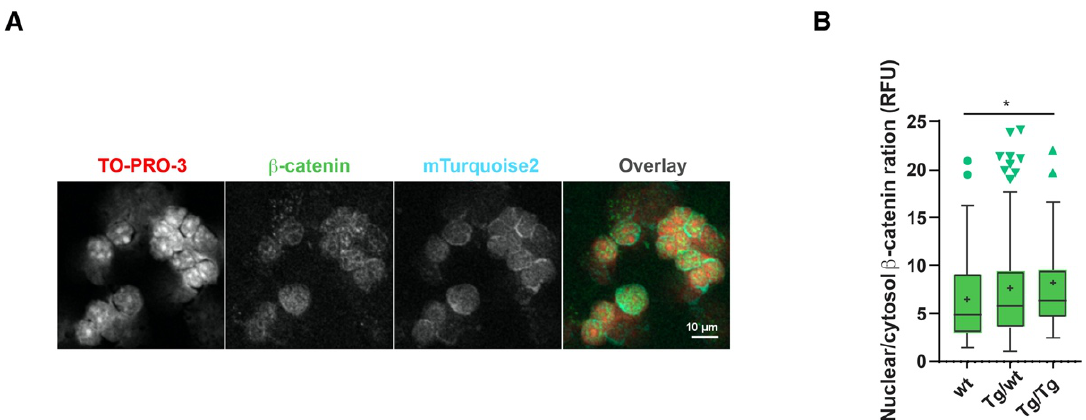
Figure 5. Axin2 allele deficiency leads to increased canonical Wnt signaling. Measurement of Axin2- mTurquoise2 and β -catenin expression by confocal imaging in thymocyte cytospin preparations. ( A ) Confocal grayscale and overlay representation of homozygote (Tg/Tg) Axin2-mTurquoise2 total thymocytes stained with nuclear TO-PRO- 3 and total β -catenin AF568, as well as endogenous cytoplasmic mTurquoise2 expression. Images were taken at 40x with 1.5 zoom factor. ( B ) Boxplot ratio representation of nuclear (active) to cytoplasmic (inactive) total β -catenin AF568 intensity values from wild-type (wt), heterozygous (Tg/wt) and homozygous (Tg/Tg) Axin2-mTurquoise2 mice (50- 70 cells per genotype). Data bars represent median values; protruding data points are outliers from the median boxplot; + signs represent mean values. Error bars represent Tukey whiskers. * p <0.033 (Mann–Whitney U test).